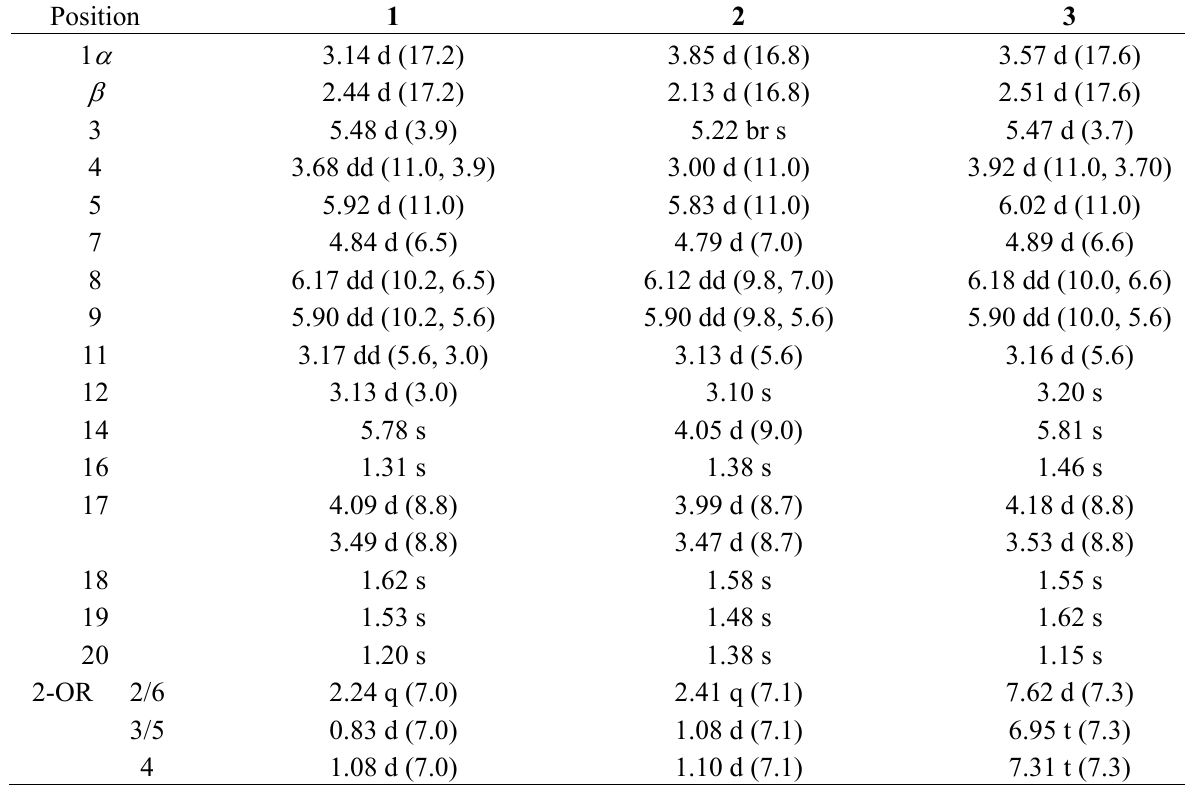
Table 1. 1 H-NMR spectroscopic data for compounds 1 – 3 (  ppm in CDCl